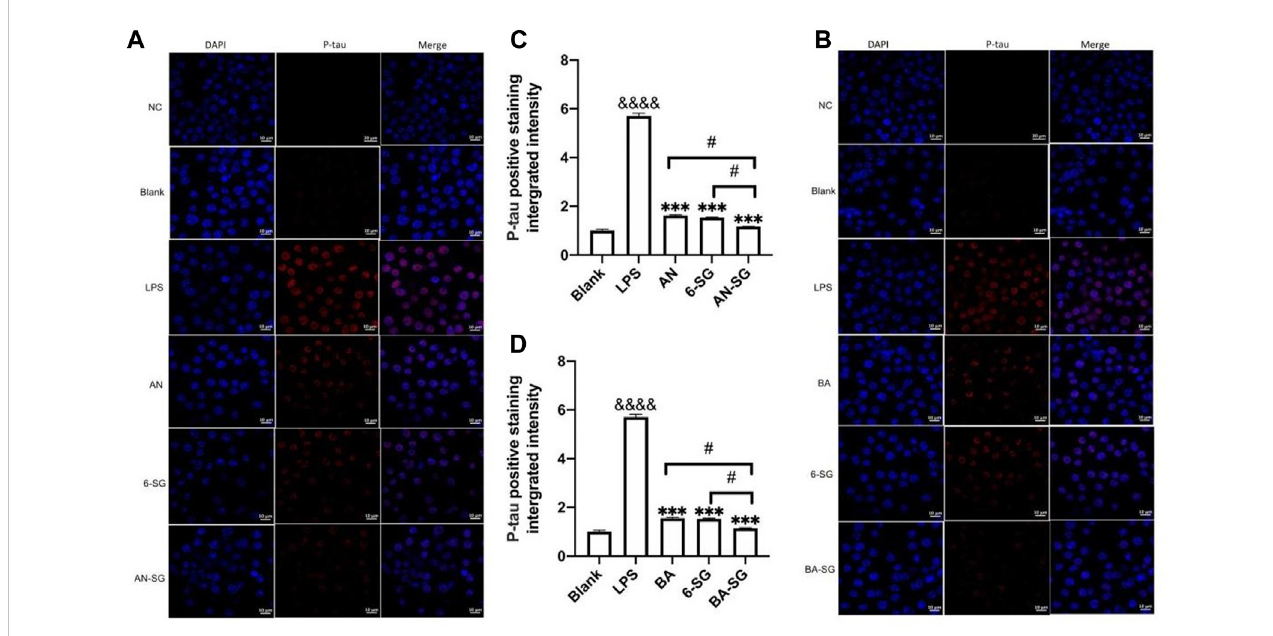
FIGURE 8 AN-SGandBA-SGexhibitedgreaterp-taureductioninN2Acellsofthetri-culturesystemagainsttheLPSstimulationcomparedwiththeircorresponding individualcomponent.Immuno fl uorescencestainingofp-taufor (A) AN-SGand (B) BA-SGgroupsaftertheexposureofLPSfor0.5 h.Imagesweretakenbya confocal microscope with × 63 magni fi cation. Blue: DAPI in the nucleus. Red: p-tau in tri-cultured N2A cell lines. Scale bar = 10 μ m. Use ImageJ to quantity thetau protein phosphorylation activity. (C, D) Statistical analysis ofthe p-tau expression byAN-SGand BA-SGusing ImageJ. Data are shown as mean ± SEM ( n > 3). &&&& p < 0.0001 vs. Blank, *** p < 0.001 vs. LPS, # p < 0.05 vs. combination, by one-way ANOVA analysis and Tukey test for group comparison in GraphPad Prism